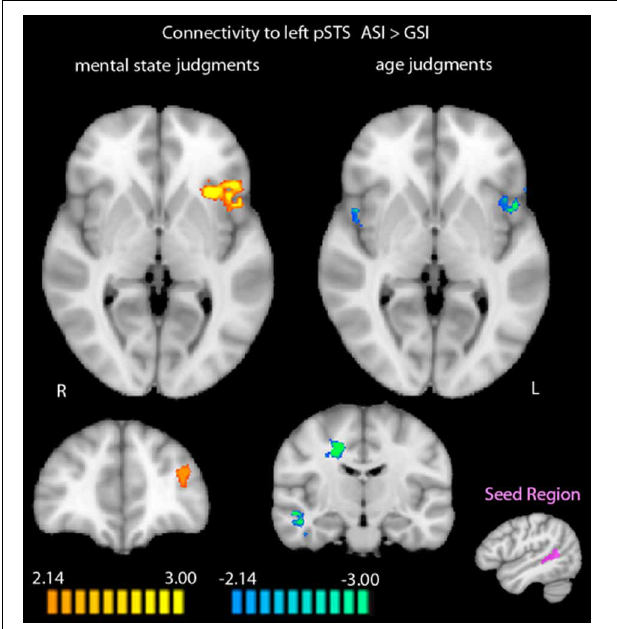
FIGURE 3 | Differential functional connectivity to the left posterior STS during mental state and age judgments after the ASI vs. the GSI. Regions in orange showed greater functional connectivity to the left posterior STS during judgments post-ASI. Regions in blue showed greater functional connectivity to the left posterior STS during judgments post-GSI ( p < 0 . 05, k = 34). The seed region for the connectivity analysis (shown in purple) was defined by greater activation to mental state judgments compared with age judgments in the RMET-R at baseline. Data is interpolated to 1mm 3 resolution for presentation.